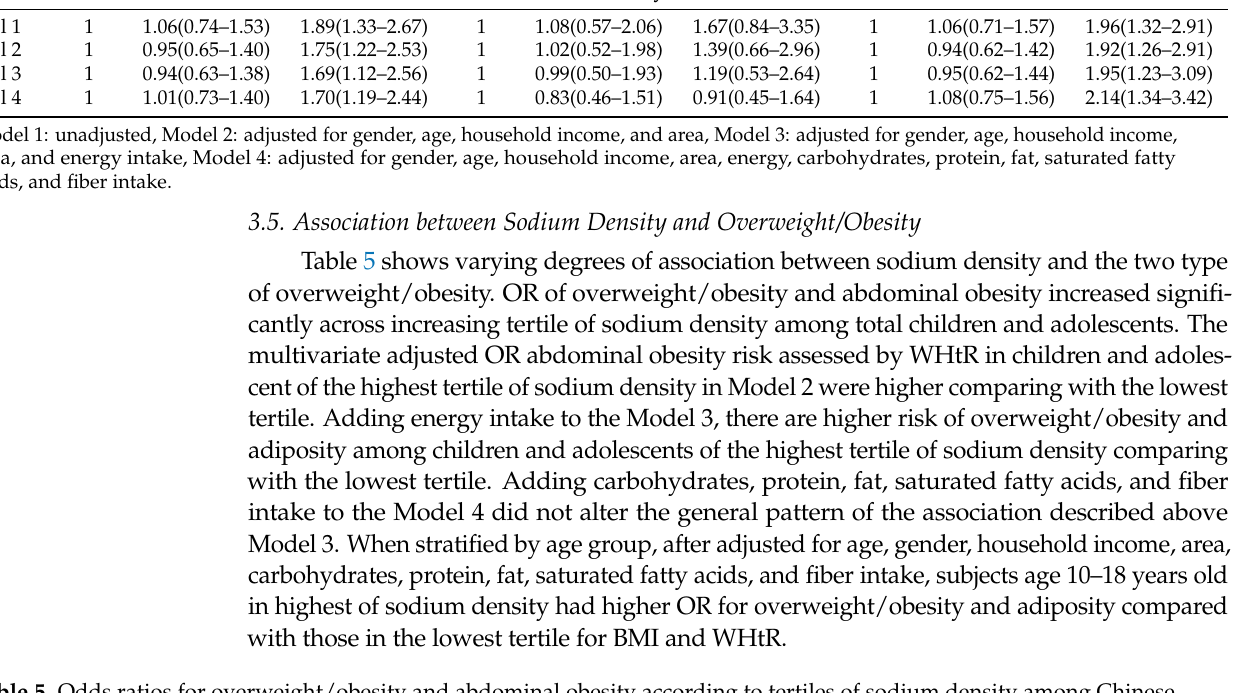
Table 5. Odds ratios for overweight/obesity and abdominal obesity according to tertiles of sodium density among Chinese children and adolescents aged 7–18